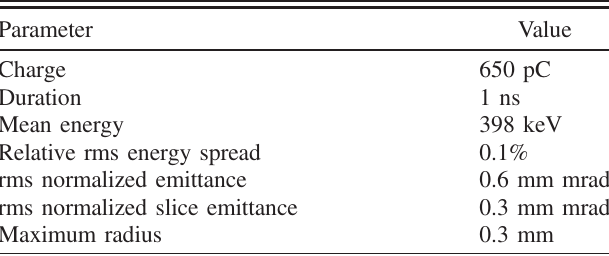
TABLE V. The bunch parameters at the output of the 3rd harmonic